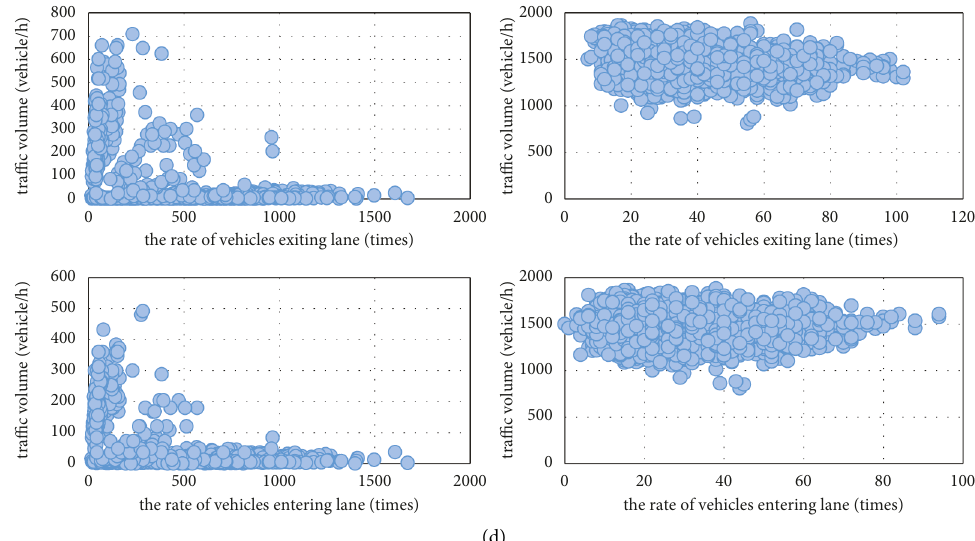
Figure 6: The relationship between traffic volume and behaviors of changing lane in different lanes in empirical study and simulation module. (a) Graph of traffic volume versus behaviors of changing lane in lane 1. (b) The relationship between traffic volume and behaviors of changing lane in lane 2. (c) Graph of traffic volume versus behaviors of changing lane in lane 3. (d) The relationship between traffic volume and behaviors of changing lane in lane